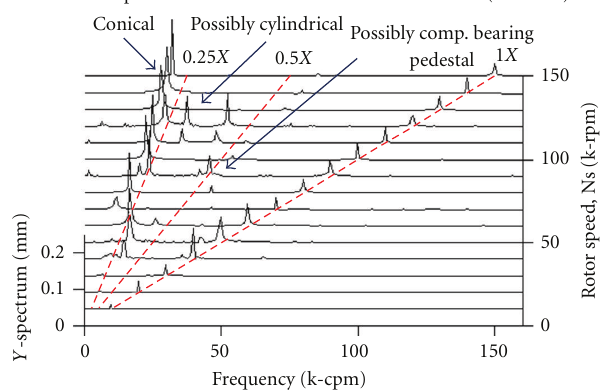
Figure 7: Frequency spectrum (waterfall) of a turbocharger with inherited unbalance in nonlinear floating ring bearings, computed at the compressor end tip (station 1).